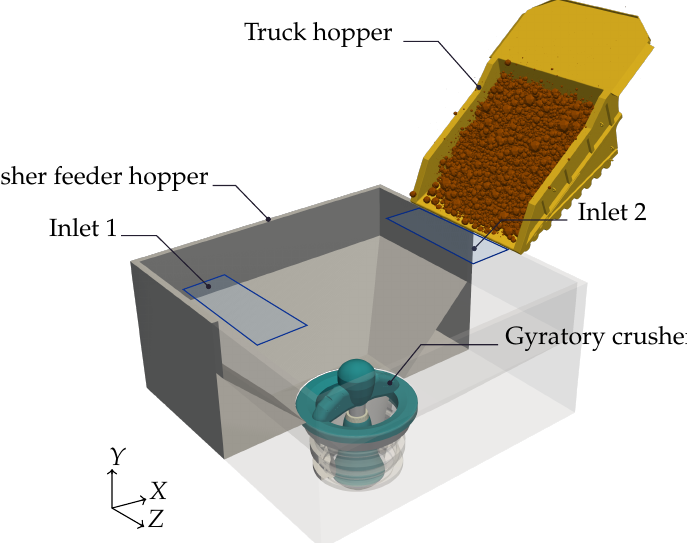
Figure 5. Schematic diagram of the primary crusher used in DEM simulation and the complete setup, showing the truck hopper, crusher feeder hopper, and two rectangular inlets.